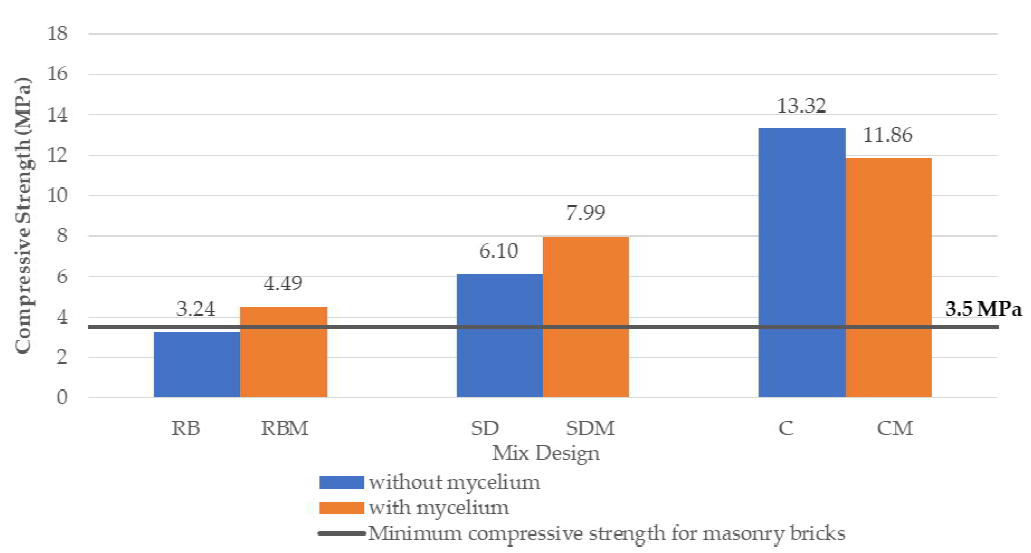
Figure 6. Compressive strength of bricks with and without mycelium.